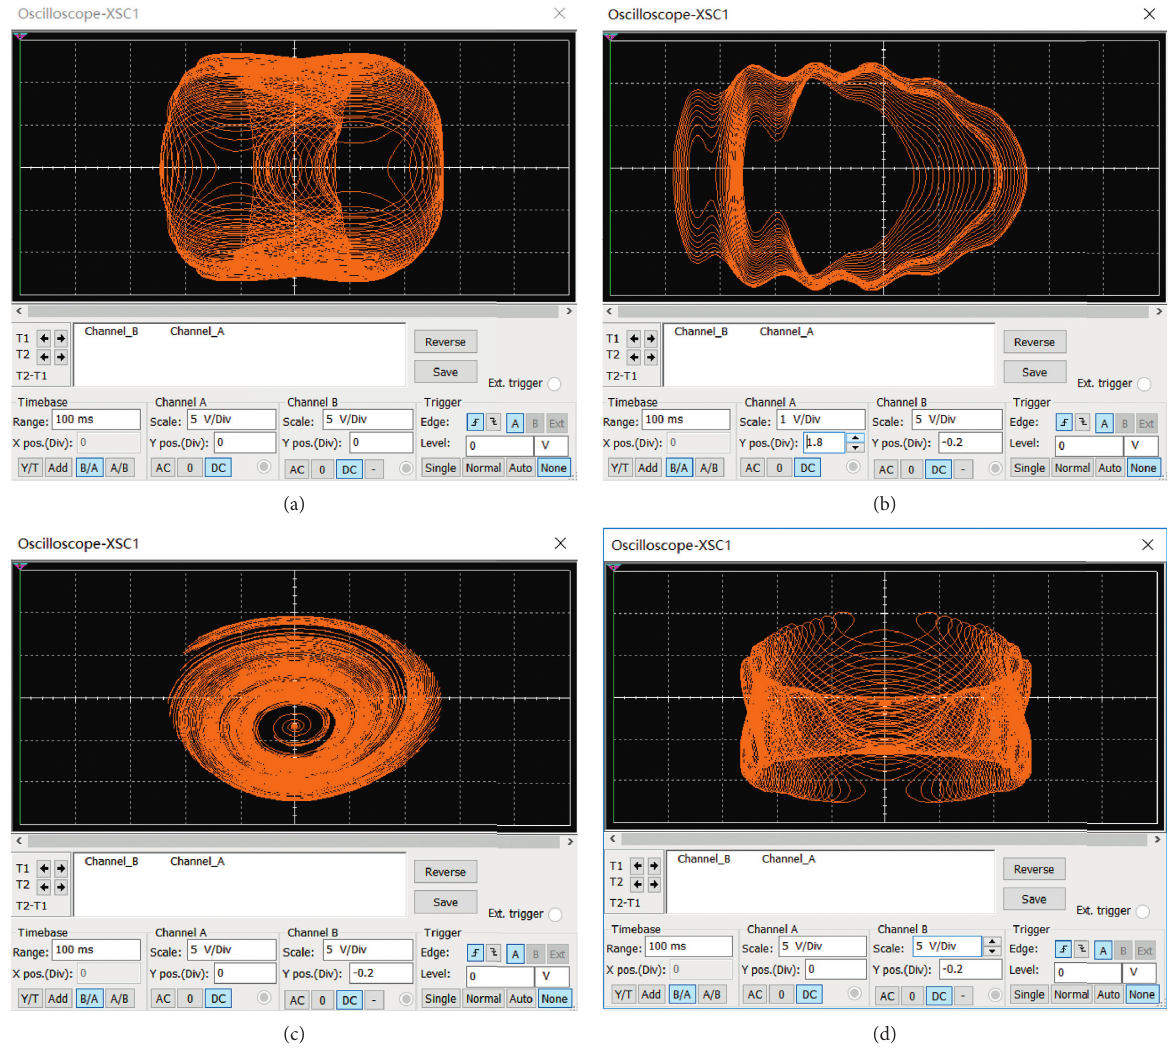
Figure 11: Circuit simulation phase diagram. (a) yz phase diagram. (b) xz phase diagram. (c) yw phase diagram. (d) zw phase